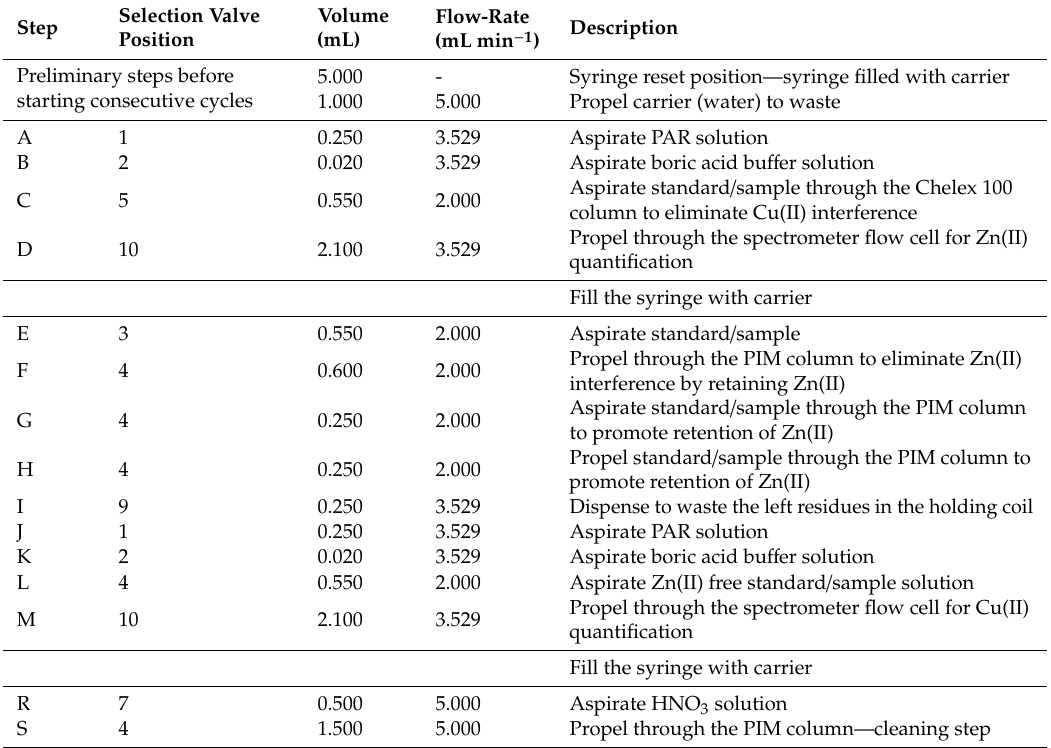
Table 4. Experimental protocol for the copper(II) and zinc(II)